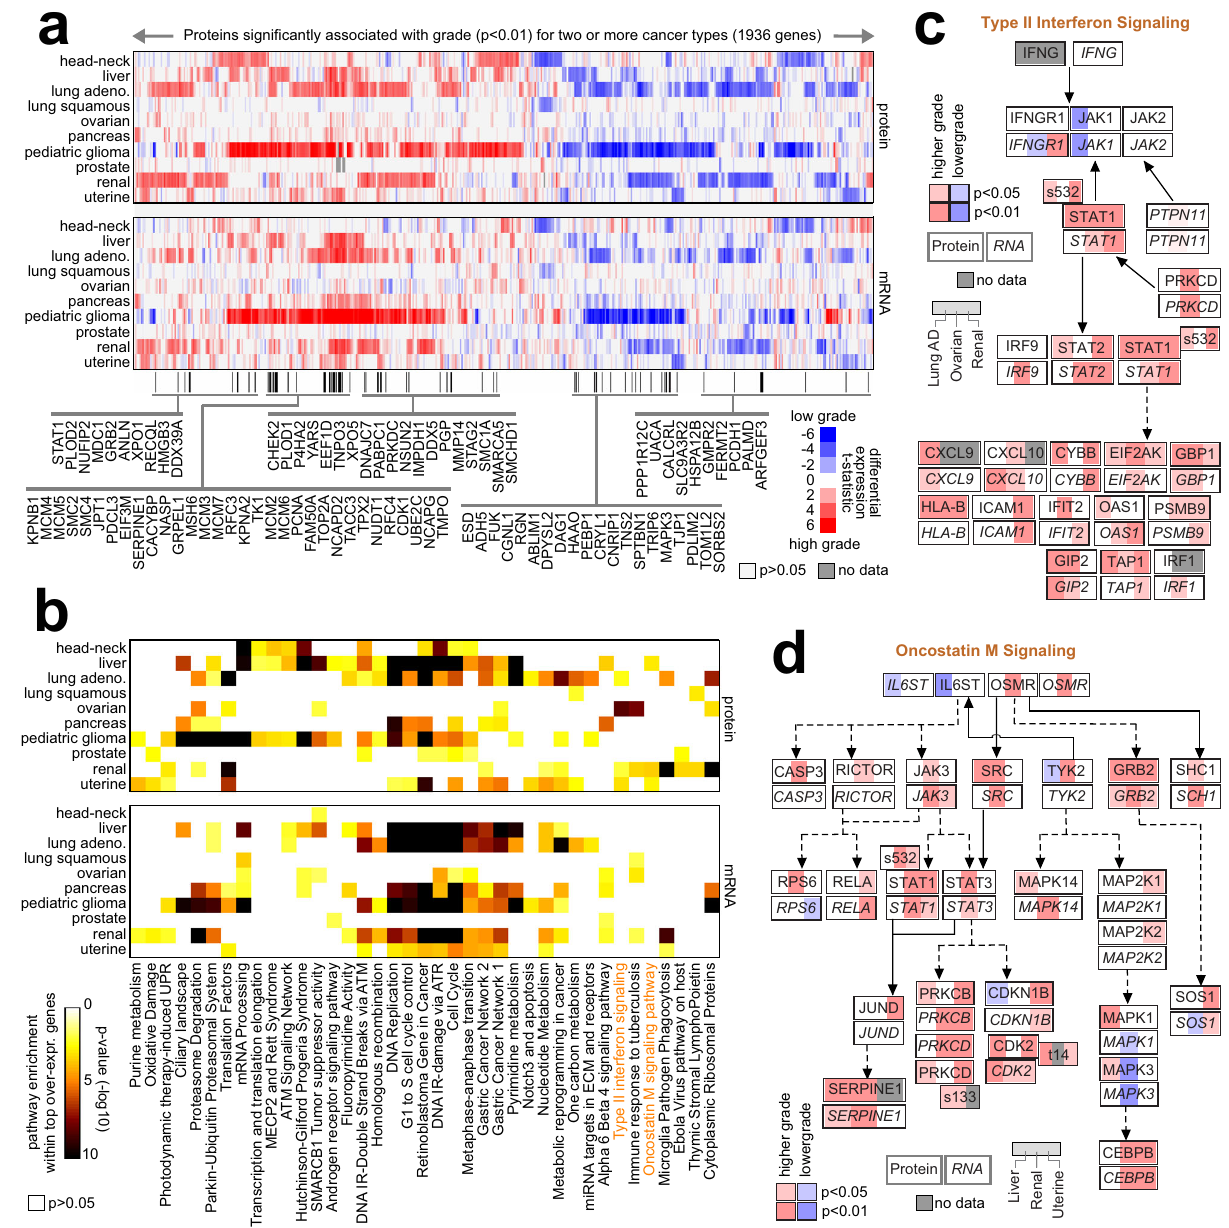
Fig. 2 Proteomic and transcriptomic signatures of high-grade cancers. a Across ten cancer types with tumor grade information, heat map of differential t - statistics (Pearson correlation on log-transformed data), by cancer type, comparing higher grade versus lower grade (red, higher expression with higher grade; white, not signi fi cant with p > 0.05), for 1936 proteins signi fi cant for two or more cancer types ( p < 0.01). Differential t -statistics by grade for the mRNA corresponding to the 1936 proteins are also shown. Proteins signi fi cantly over-expressed ( p < 0.01) with higher grade for four or more cancer types are indicated by name. b Signi fi cance of enrichment (by one-sided Fisher ’ s exact test) for wikiPathway 28 gene sets with the respective sets of proteins and mRNAs over-expressed ( p < 0.01, Pearson) with tumor grade for each cancer type represented. The pathways represented were signi fi cant within the over- expressed proteins for at least one cancer type with FDR < 10% and for at least two cancer types with p < 0.01. c Pathway diagram representing type II interferon signaling, with differential protein and mRNA expression patterns represented, correlating expression with increasing tumor stage for Lung AD (adenocarcinoma), Ovarian, and Renal cancer types. RNA features are indicated using italics. Phospho-protein features are indicated by residue. Red denotes signi fi cantly higher expression with higher grade, and blue denotes signi fi cantly lower expression. d Similar to c , but for Oncostatin M signaling and cancer types Liver, Renal, and